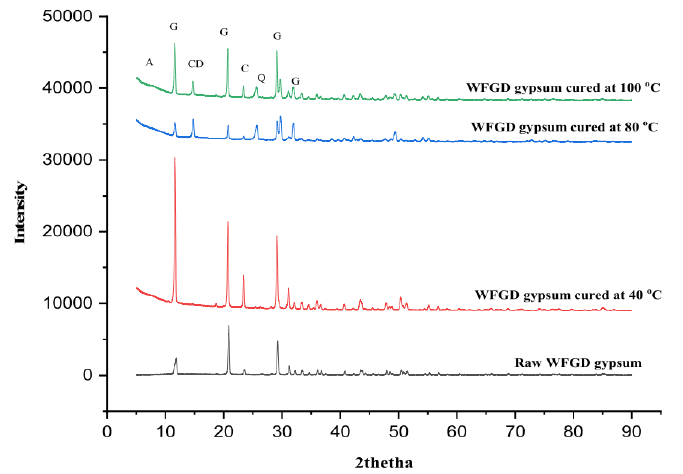
Figure 13. X-ray patterns of raw gypsum and those cured at elevated temperatures (A = sillimanite, Q = quartz, CD = calcium dialuminate, C =